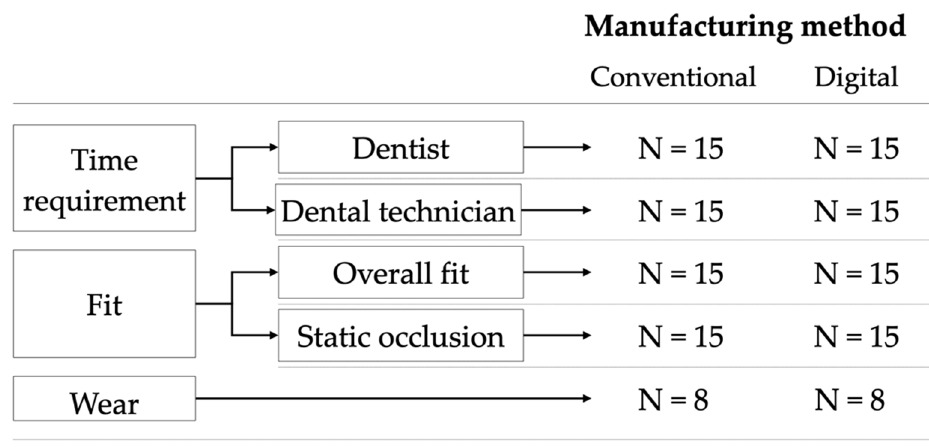
Figure 1. Experimental setup. N = number of Michigan splints fabricated and examined.